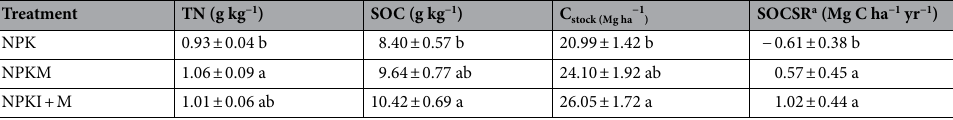
Table 4. TN, SOC, C stock and SOCSR at 0–20 cm soil depth after four year’s different fertilization treatments. a The SOCSR was estimated from April 2012 to October 2015. Values followed by different lowercase letters at the same column indicated significant difference ( P < 0.05) among the